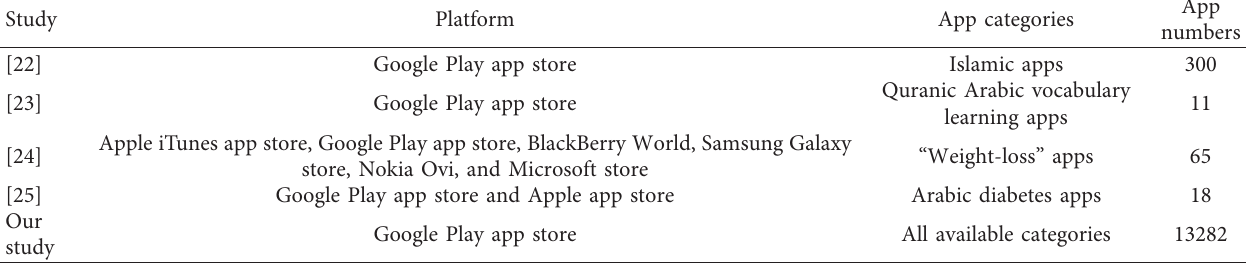
Table 1: Summary of Arabic app studies.